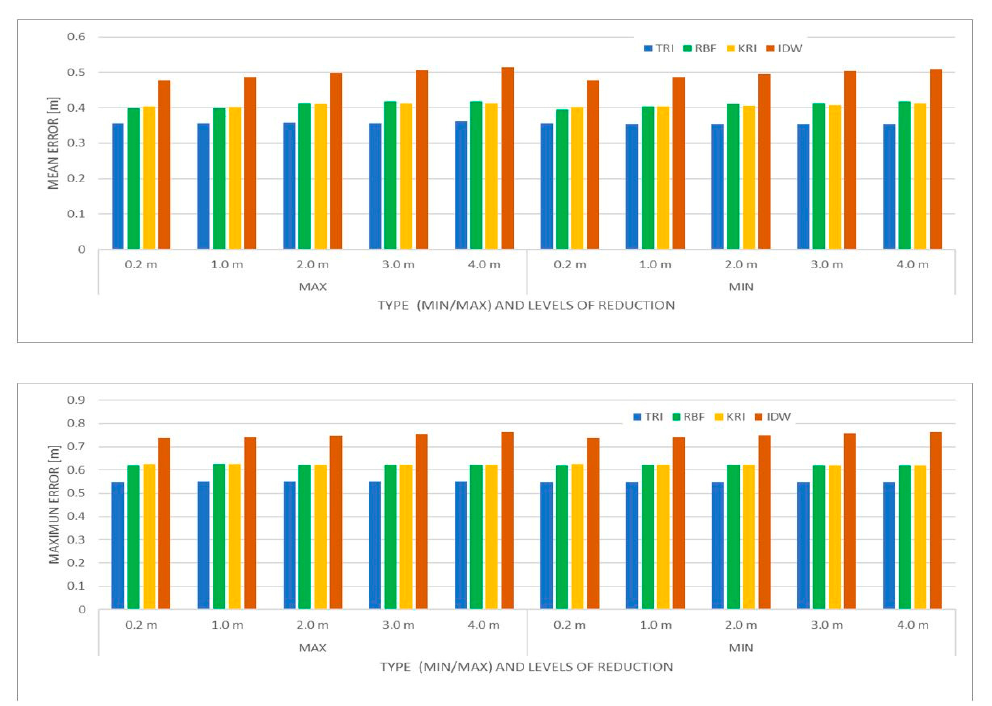
Figure 11. Summary of mean errors for the water area without data.